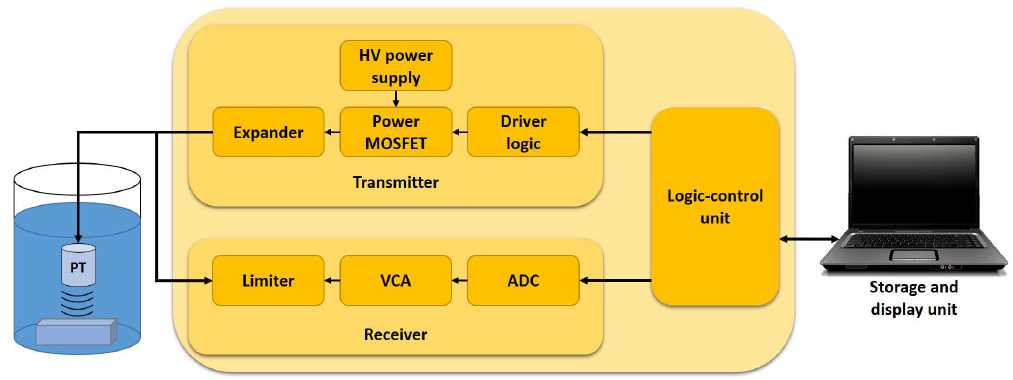
Figure 2. Typical architecture of an ultrasound system for immersion